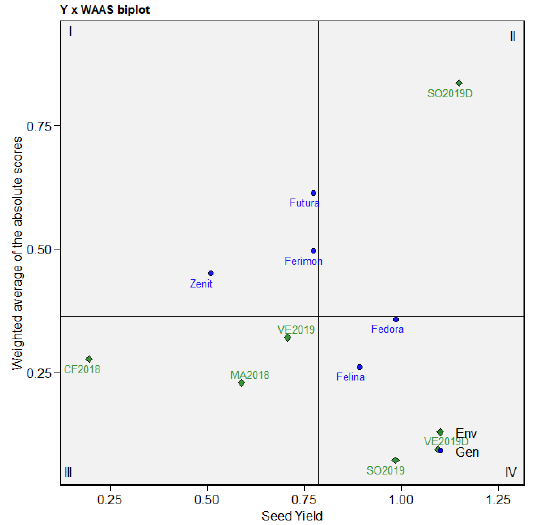
Figure 3. Biplot of the seed yield (Mg ha − 1 ) vs. the WAAS of 5 cultivars evaluated in 6 environments.